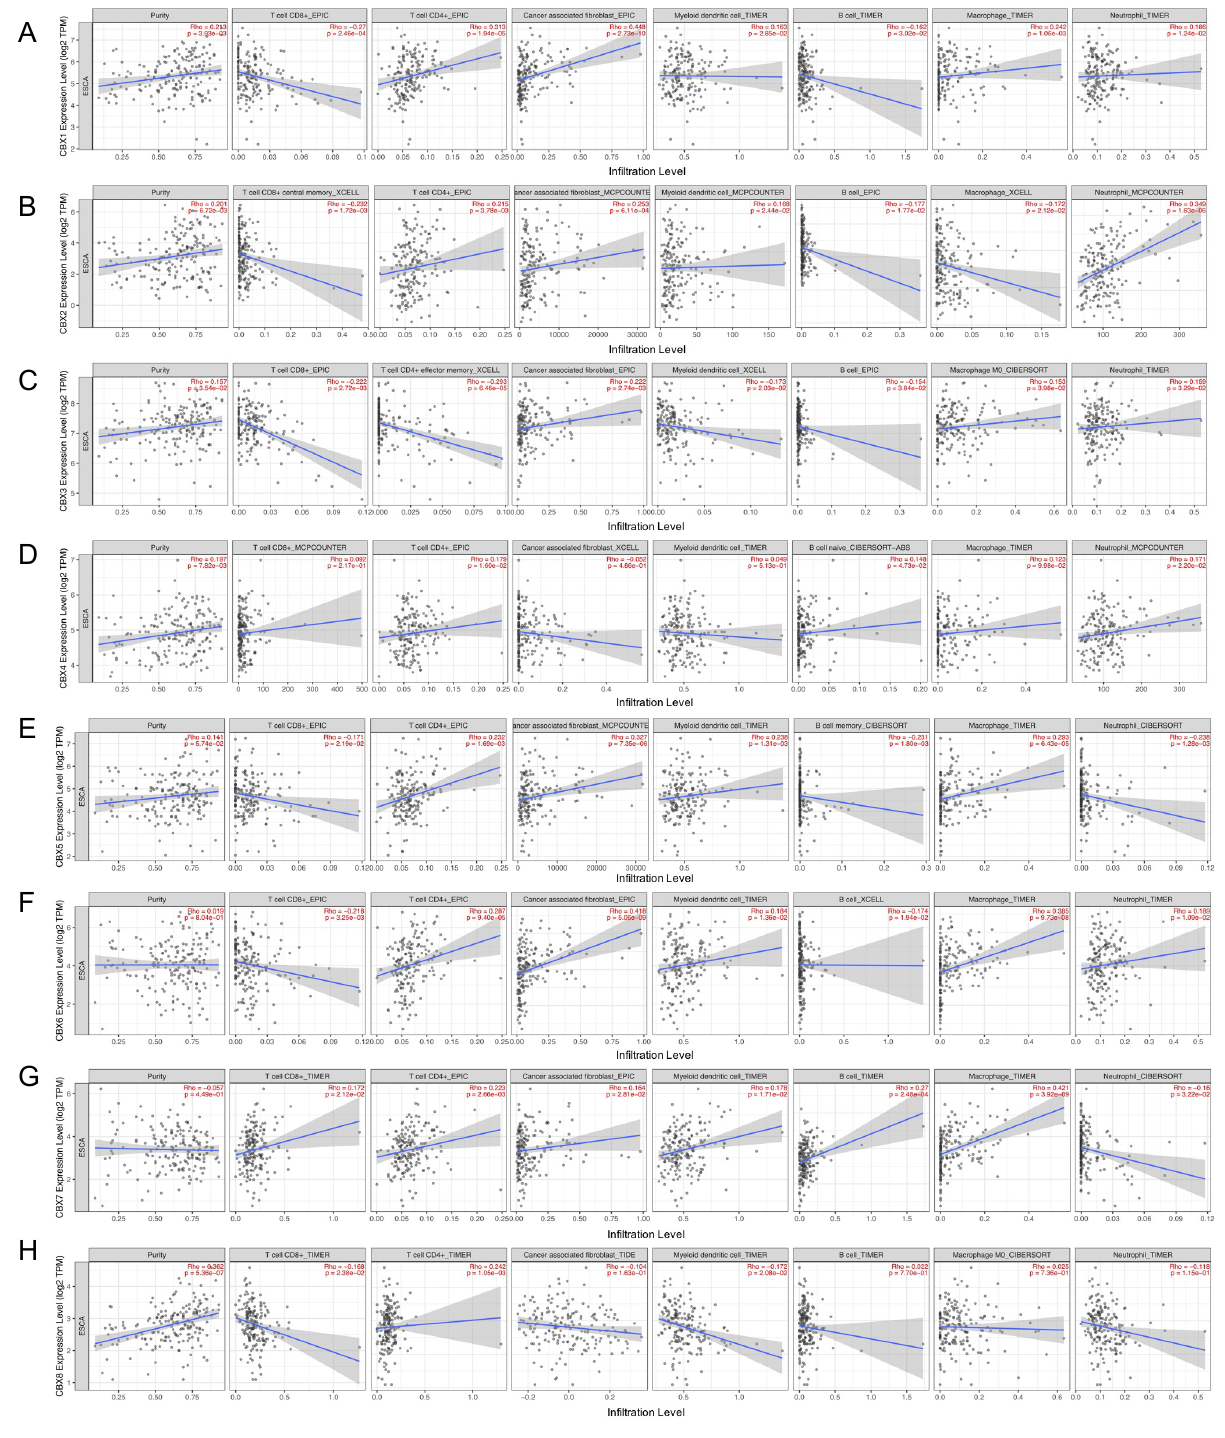
Figure 7. Relationships between CBX1-8 and immune cells infiltration level ( A – H ). (TIMER2, Rho > 0, positively correlated; Rho < 0, negatively